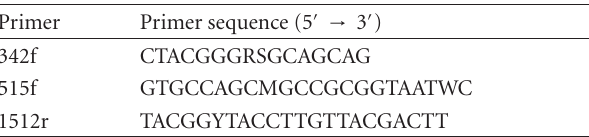
Table 3: Tissue samples which were not microdissected. Table 4: PCR